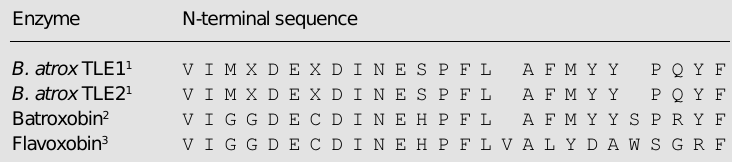
Table 3 - N-terminal sequence of the two forms of B. atrox thrombin-like enzyme (TLE) and comparison with other proteases. 1 Present study; 2 Ref. 12; 3 Ref.